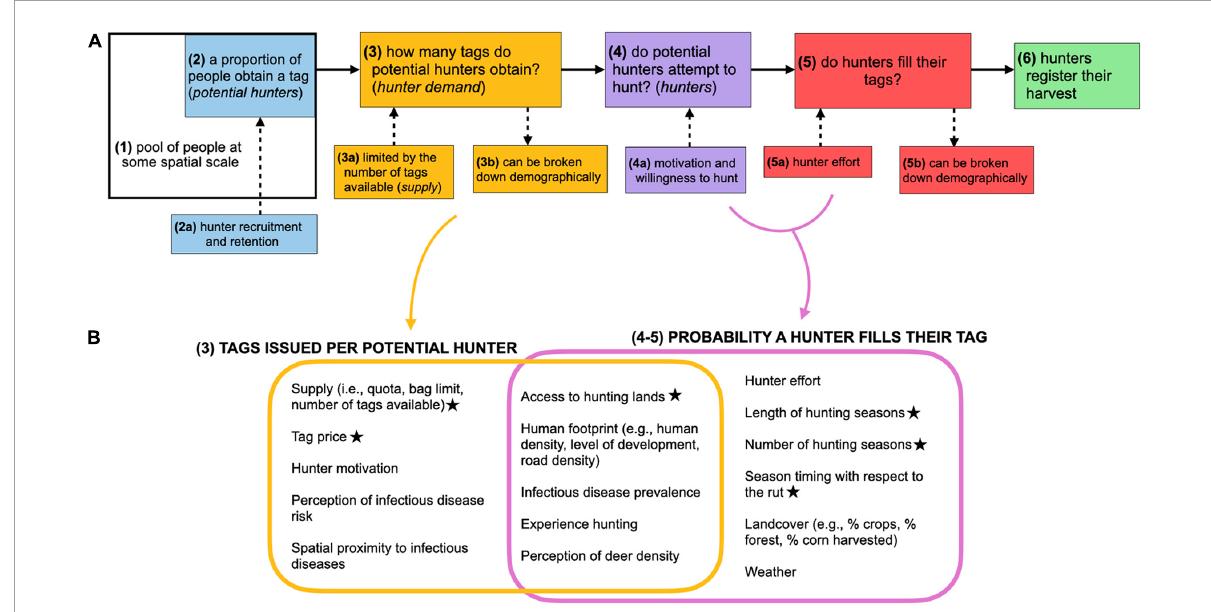
FIGURE1 (A) Flowchart depicting the schematic decomposition of the processes affecting hunter harvest. Solid arrows represent conditional, ordered processes; dashed arrows represent influences or components of processes [e.g., (5a) hunter effort, or hours hunted/day, influences (5) the probability a hunter fills their tag]; colored arrows show the hunting processes that are displayed in panel (B) . (B) Venn-diagram of potential factors driving the number of tags a hunter obtains [ (A) : (3)] and the probability that a hunter fills their tag [e.g., kills an animal; (A) : (4, 5)]. Stars in panel (B) denote factors that are controlled or influenced by wildlife management